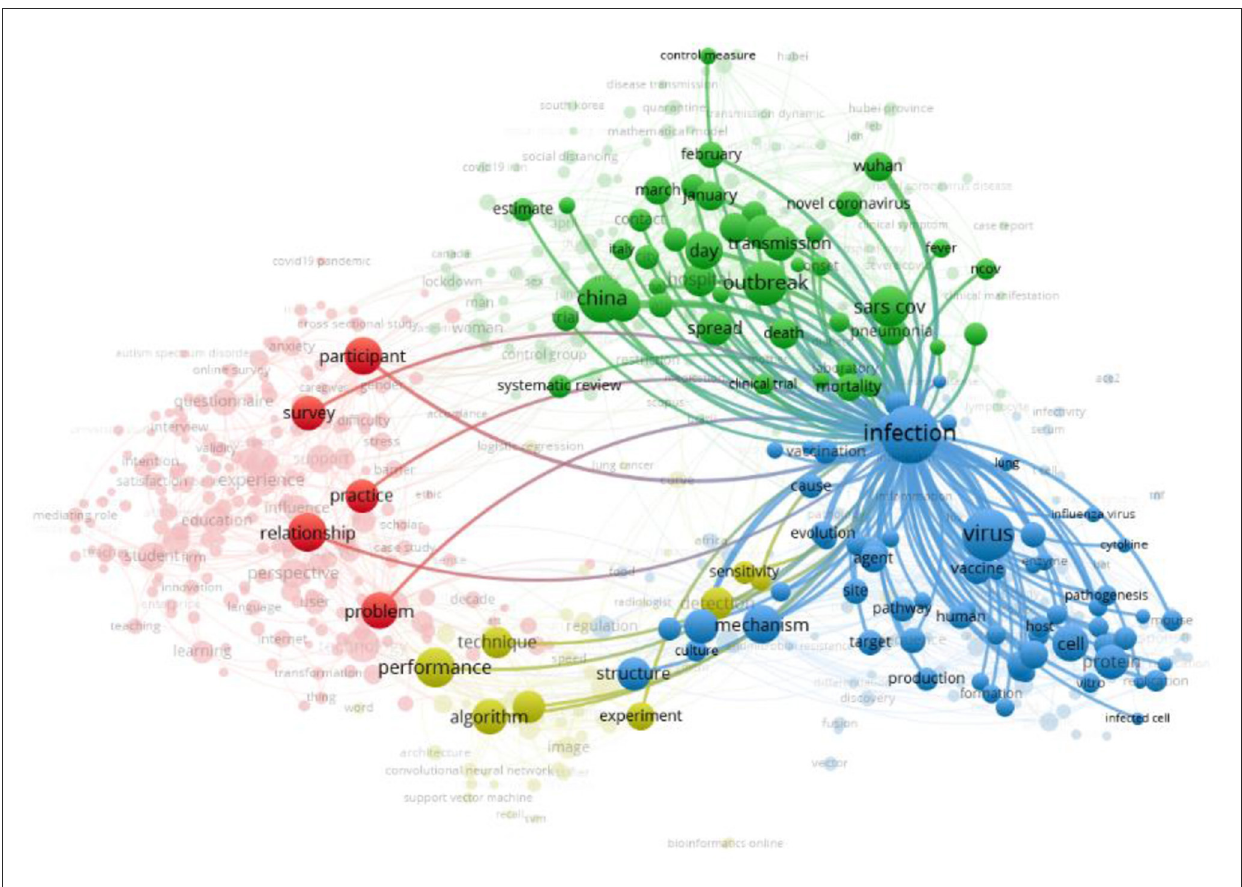
FIGURE3 Network visualization map of the term “infection”.